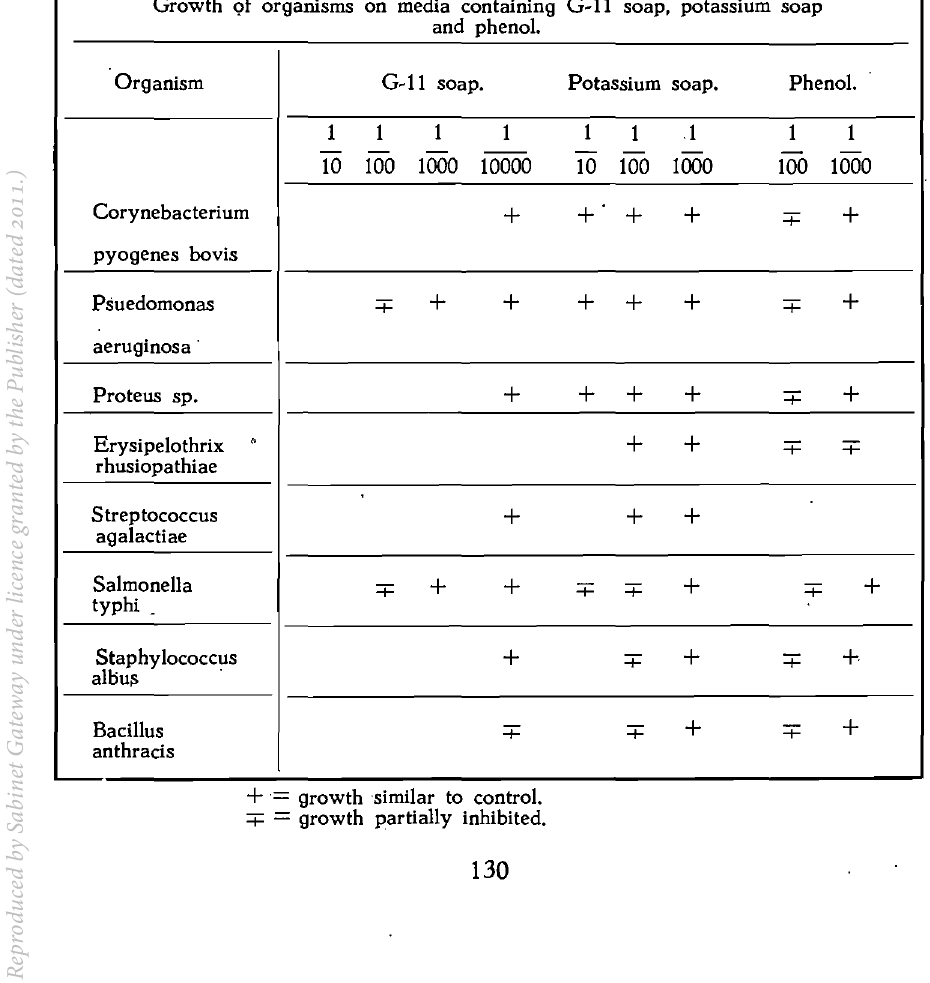
Growth <;If organisms on media containing